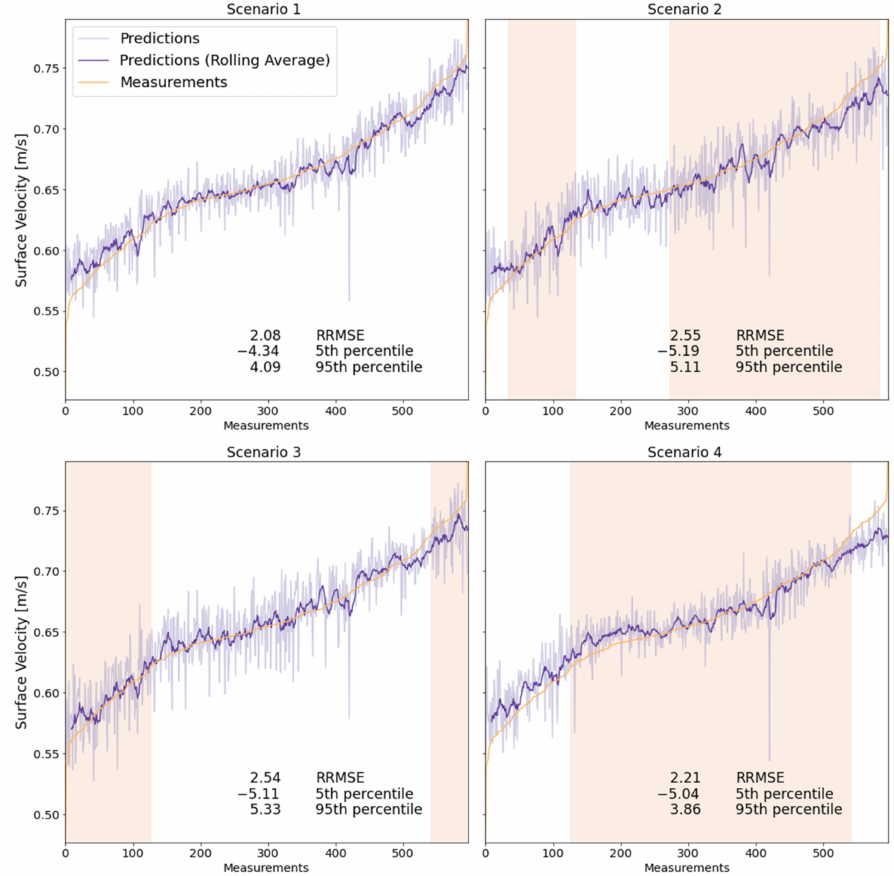
Figure 5. Surface velocity evaluation and relative errors for Scenario 1—base case, Scenario 2—two gaps, Scenario 3—no extreme values, and Scenario 4—only extreme values. Shaded areas repre- sent missing training data, i.e., surface velocities that were never observed during training and need to be fully interpolated by the network. Underneath each scenario, the predictor perfor- mance is summarized with the error band of [5th percentile error, relative root mean squared error, 95th percentile error].